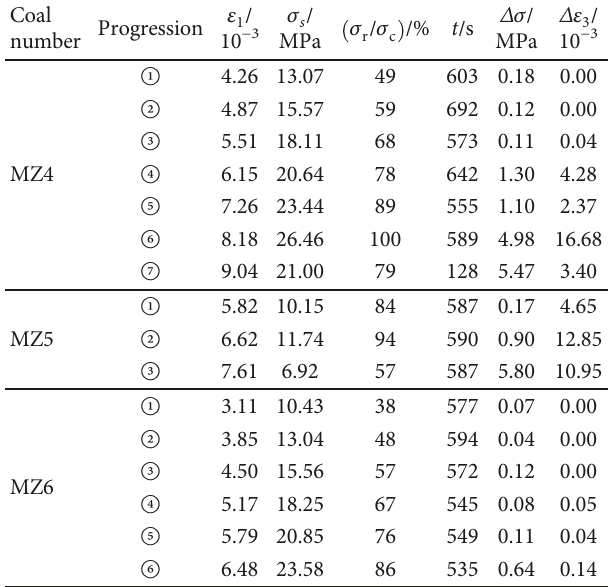
Table 2: Test results of the uniaxial compression step relaxation tests.